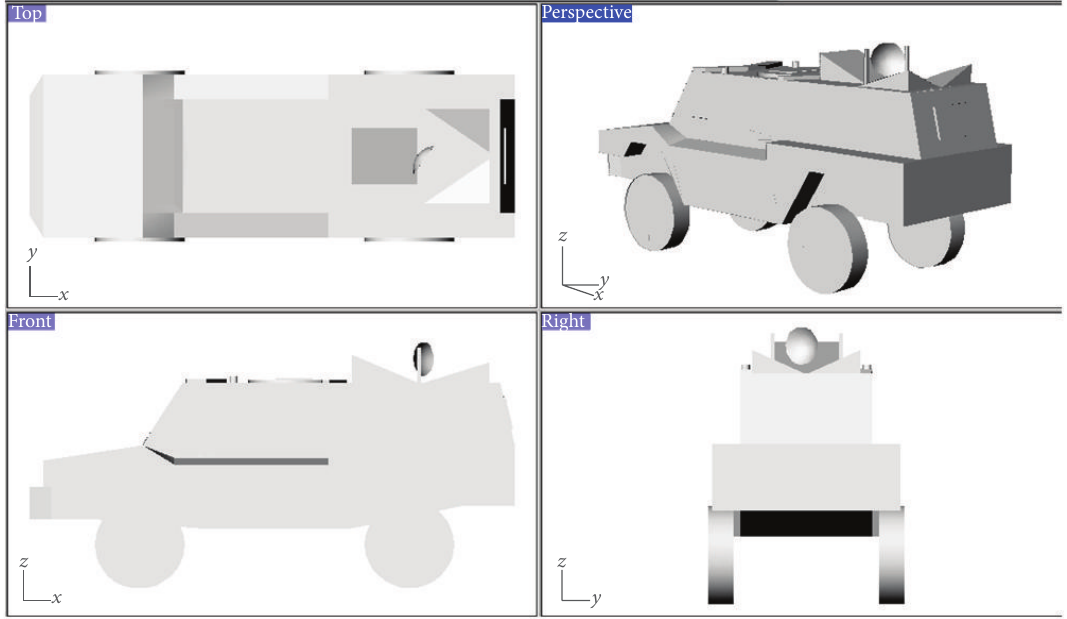
Figure 33: Different views of the reinforced vehicle.